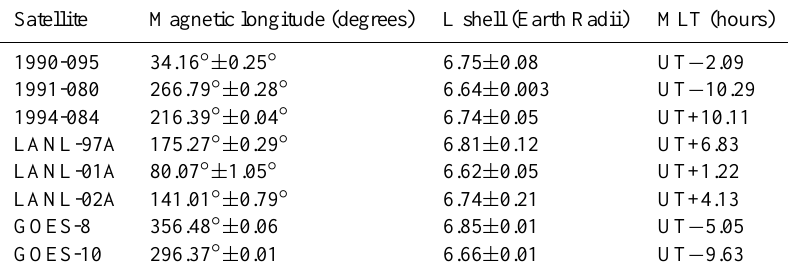
Table 2. Satellites used in this study. Columns from left to right display the following: satellite name/number; mean magnetic longitude with maximum/minimum indication; mean L-shell with extremes indicated; magnetic local time in terms of universal time. These parameters have been calculated using the International Geomagnetic Reference Field